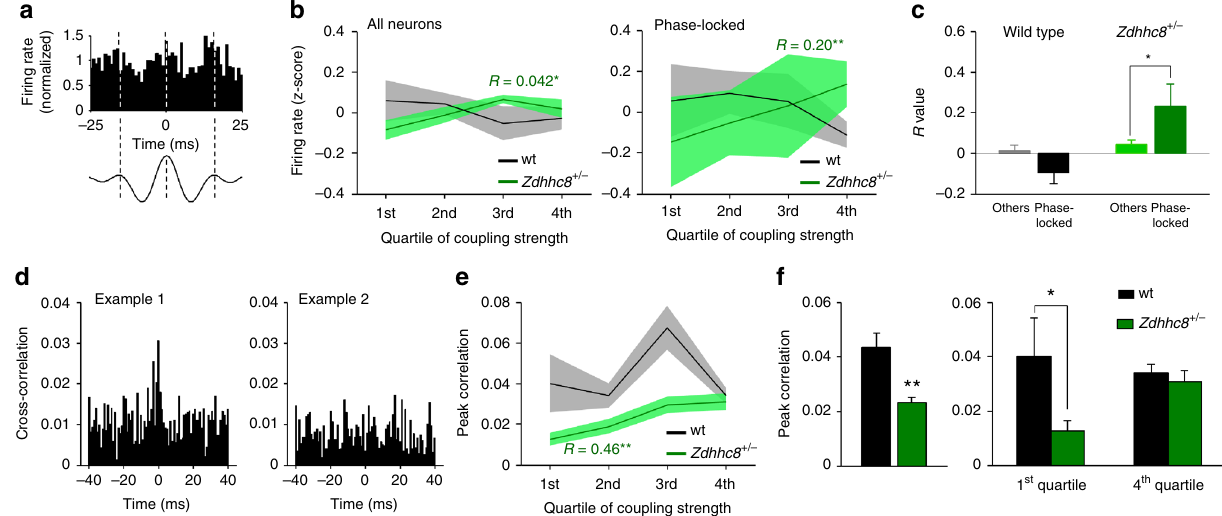
Fig. 6 vHPC theta – mPFC slow gamma coupling drives mPFC synchrony in Zdhhc8 + / − mice. a Example fi ring rate of an mPFC single unit obtained by aligning at the peak of slow gamma oscillations in the mPFC. Dashed lines illustrate peaks of gamma cycles. b Firing rates as a function of strength of vHPC theta – mPFC slow gamma coupling for all neurons (left) and signi fi cantly phase-locked neurons (right). Z-score of fi ring rate was averaged within animals, then across animals. Coupling strength was positively correlated with fi ring rate of both of phase-locked and all neurons in Zdhhc8 + / − mice (all neurons: wt; p = 0.52, Zdhhc8 + / − ; p = 0.029, Phase-locked neurons: wt; p = 0.157, Zdhhc8 + / − ; p = 0.00094). R : correlation coef fi cient. ** p < 0.01, * p < 0.05; multiple regression analysis. n = 288 neurons from 8 wild type and n = 293 from 8 Zdhhc8 + / − mice. c Mean correlation coef fi cient of fi ring rates and vHPC theta – mPFC slow gamma coupling for signi fi cantly phase-locked neurons and non-signi fi cantly phase-locked neurons (Others). Positive correlation between fi ring rate and vHPC theta – mPFC slow gamma coupling was signi fi cantly higher in phase-locked neurons of Zdhhc8 + / − mice. This tendency was not the case in wild-type control mice (wt; p = 0.15, Zdhhc8 + / − ; p = 0.047). * p < 0.05; Student ’ s t -test. d Example spike train cross-correlograms. Example 1 shows relatively higher synchrony of fi ring than example 2. e Spike cross-correlogram as a function of coupling strength. vHPC theta – mPFC slow gamma coupling was positively correlated with spike cross-correlogram only in Zdhhc8 + / − mice. ** p < 0.01; multiple regression analysis (wt; p = 0.52, Zdhhc8 + / − ; p = 0.0022). n = 30 pairs from 5 wild type and 49 pairs from 6 Zdhhc8 + / − mice. f Mean spike cross-correlogram. Left: overall spike cross-correlogram was signi fi cantly lower in Zdhhc8 + / − mice. This was reversed in higher theta – slow gamma state (Right). * p < 0.05,** p < 0.01; Student ’ s t theta – gamma coupling, cross-correlations of Zdhhc8 + / − neuron